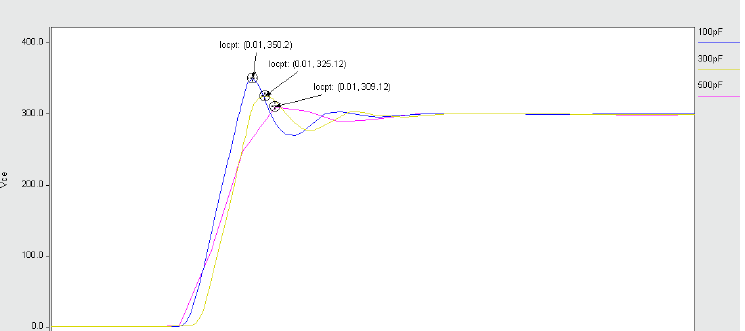
Figure 4. V ce comparison diagram under different C 1 values.